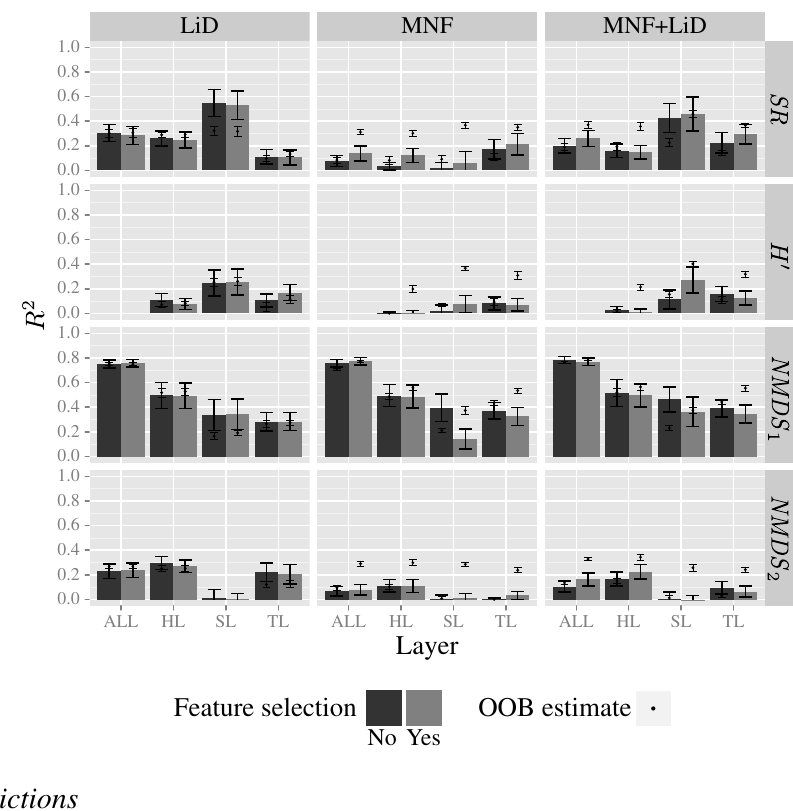
Figure 5. Model assessment of ten-fold cross-validation of random forests with and without feature selection and with mtry optimization. Response variables: Species richness ( SR ), Shannon index ( H (cid:48) ) and ordination scores ( NMDS , NMDS ). Predictor variables: 1 2 LiDAR (LiD) and hyperspectral (MNF) predictor sets and their combination (MNF+LiD). Bars: cross-validated R 2 with error bars depicting the bootstrapped standard deviation of CV R 2 . Points show the corresponding mean OOB estimates R 2 averaged over the ten CV OOB cross-validation groups together with their standard deviation in error bars. Values of R 2 below zero are artifacts of the calculation, should be interpreted as zero and are hence displayed as such. LiD MNF MNF+LiD